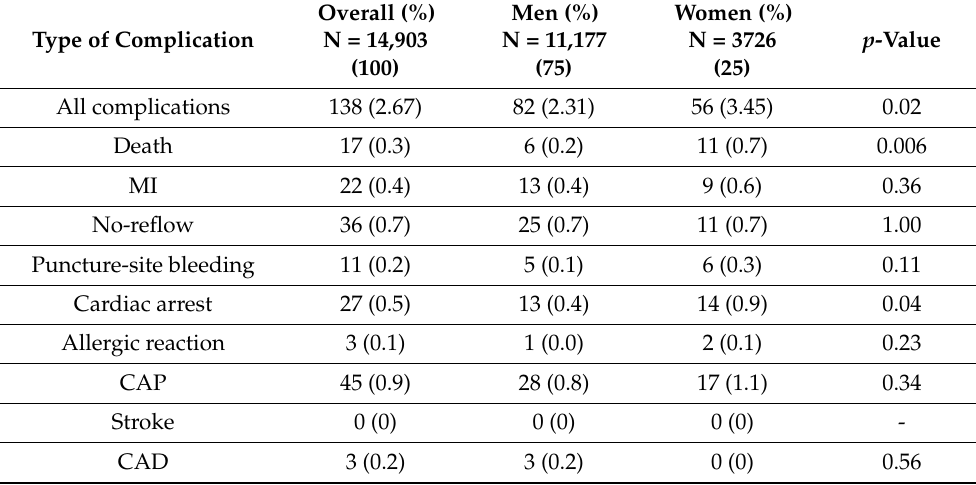
Table 3. Procedure-related complications.